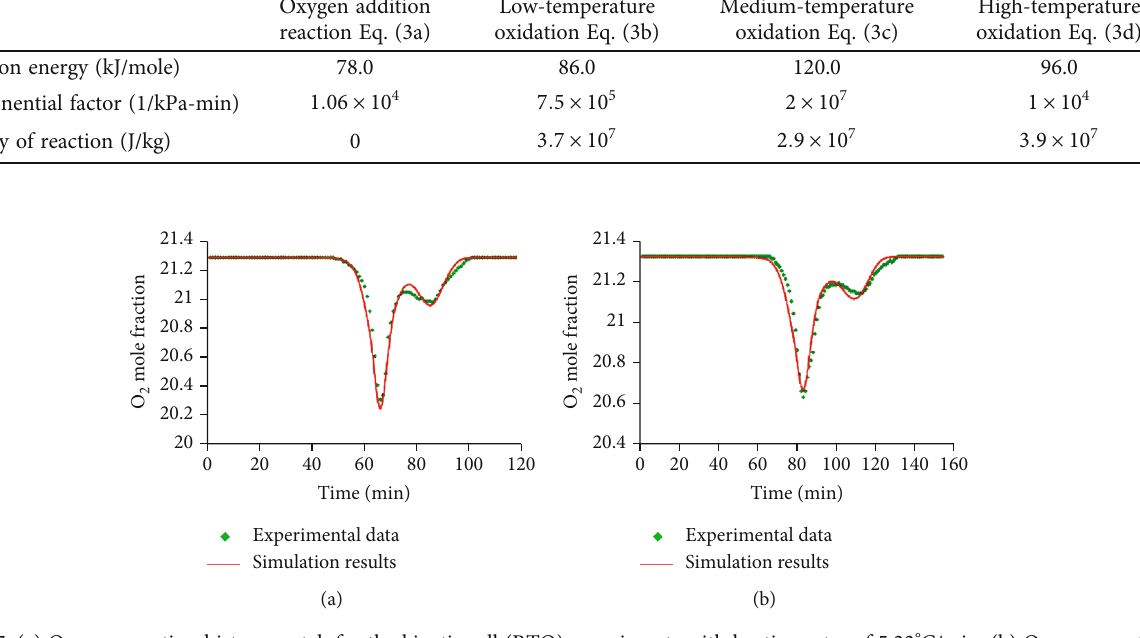
Table 2: Matched results for reaction kinetics parameters.